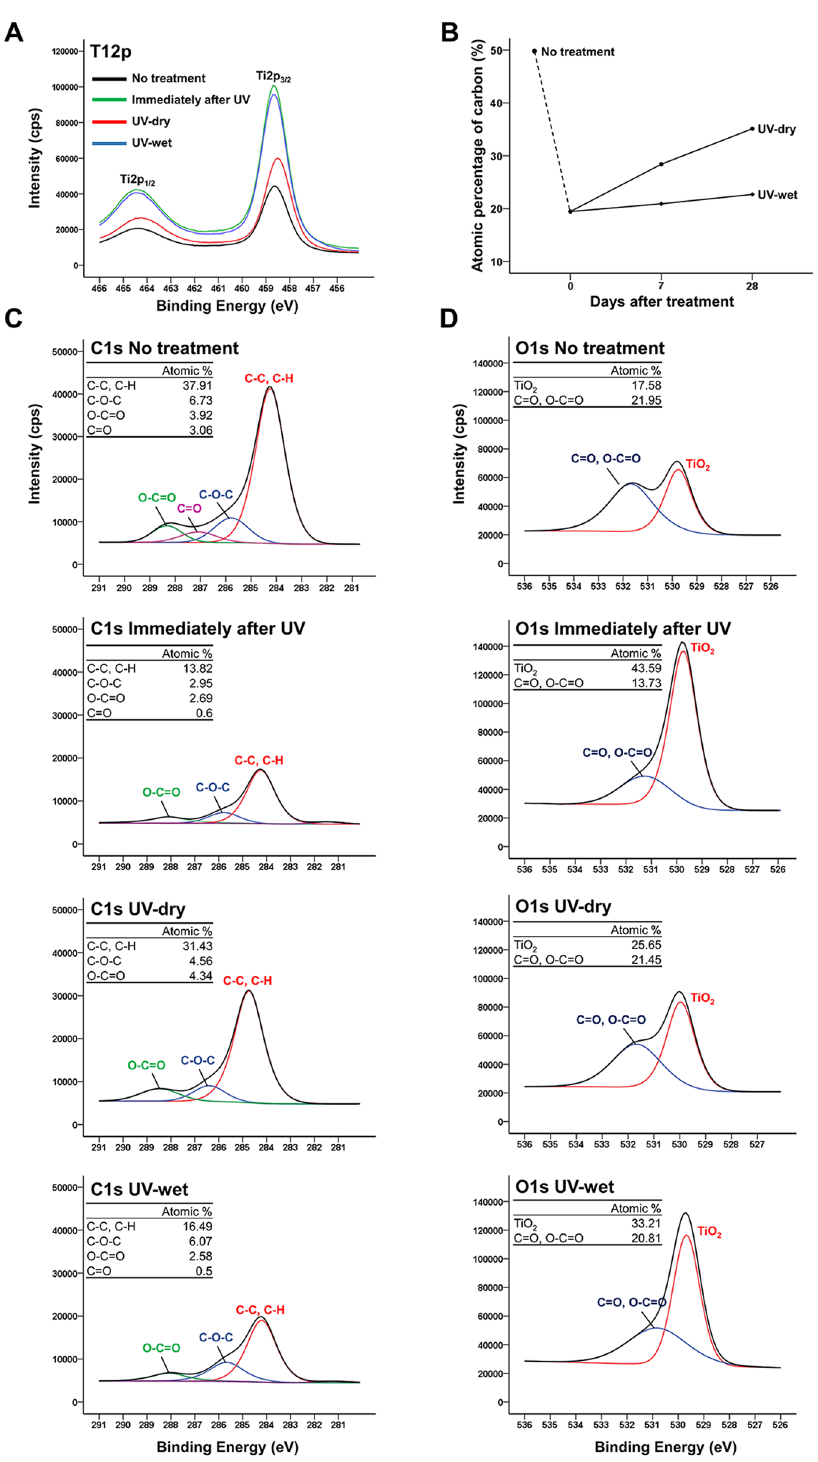
Figure 2. ( A ) Ti2p spectra immediately and 28 days after treatment, for each group. ( B ) Changes in atomic percentages of carbon over time after treatment, for each group. Changes in spectra and atomic percentages of C1s ( C ) and O1s ( D ) immediately and 28 days after treatment, for each